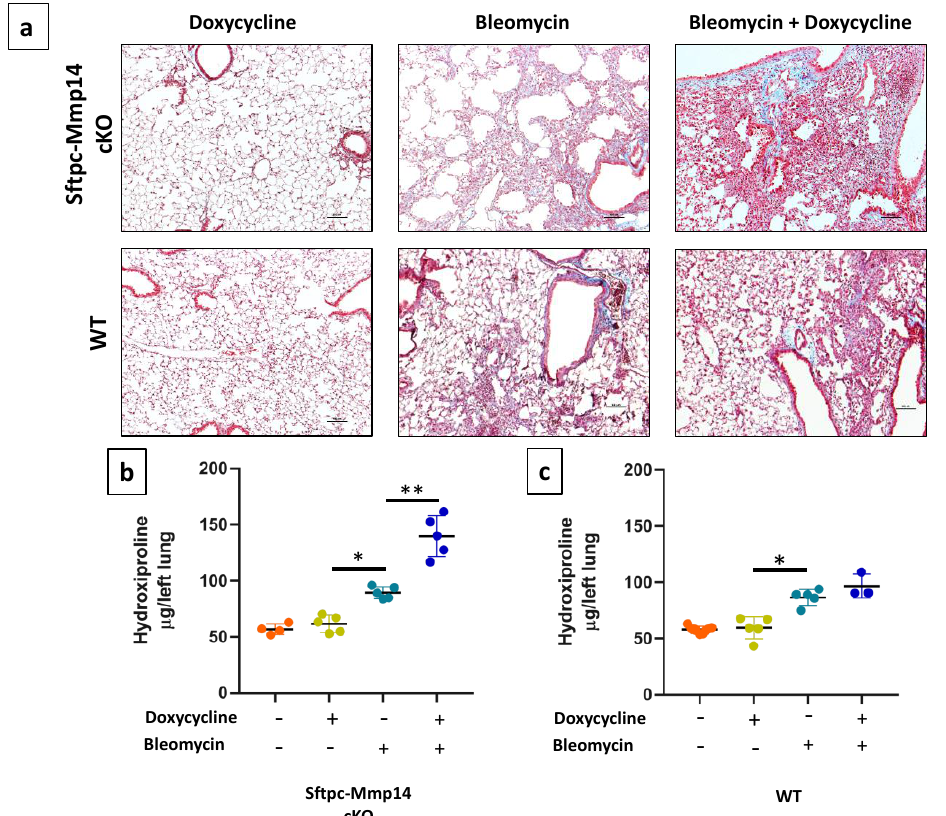
Figure 3. Lung injury induced with bleomycin in Sftpc-Mmp14 cKO and wild-type (WT) mice sacrificed at 21 days (fibrotic phase). ( a ) Representative micrograph stained with Masson’s trichrome (blue) for collagen deposition throughout the lungs of Sftpc-Mmp14 cKO and WT mice in the absence or presence of doxycycline, Scale bar 100 µ m; ( b , c ) Hydroxyproline content in Sftpc-Mmp14 cKO ( b ) and WT mice ( c ) after bleomycin treatment in the absence or presence of doxycycline. * p < 0.05, ** p < 0.01 by one-way analysis of variance (ANOVA) with Tukey post-hoc n ≥ 3. Scale 100 µ